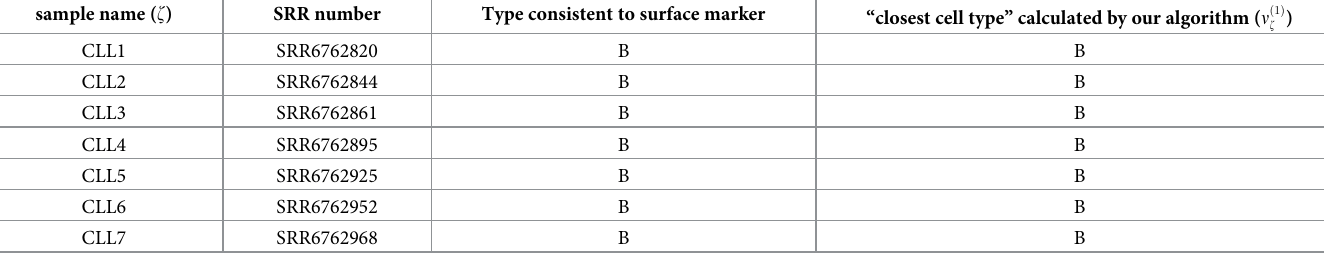
Table 3. Classification of ATAC-seq data of CLL samples. “Closest cell type” computed by our algorithm. sample name ( z